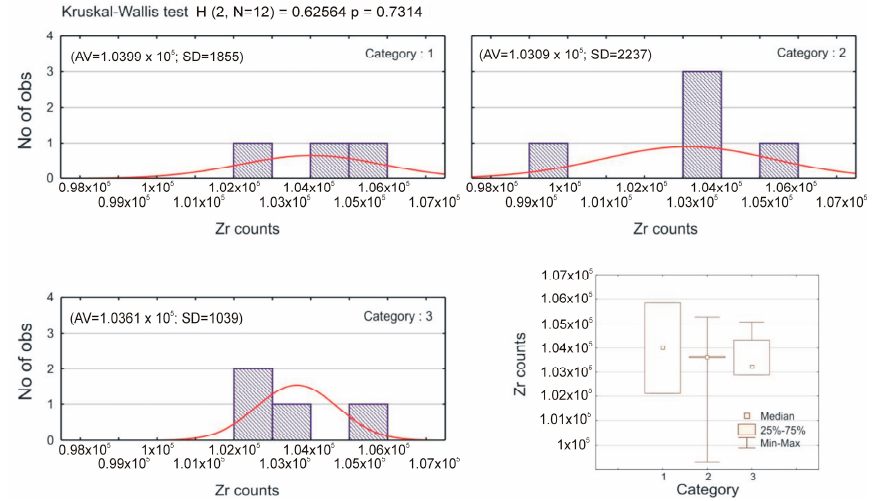
Figure 8. Results of the Kruskal–Wallis test and box ‐ plot diagram by category.